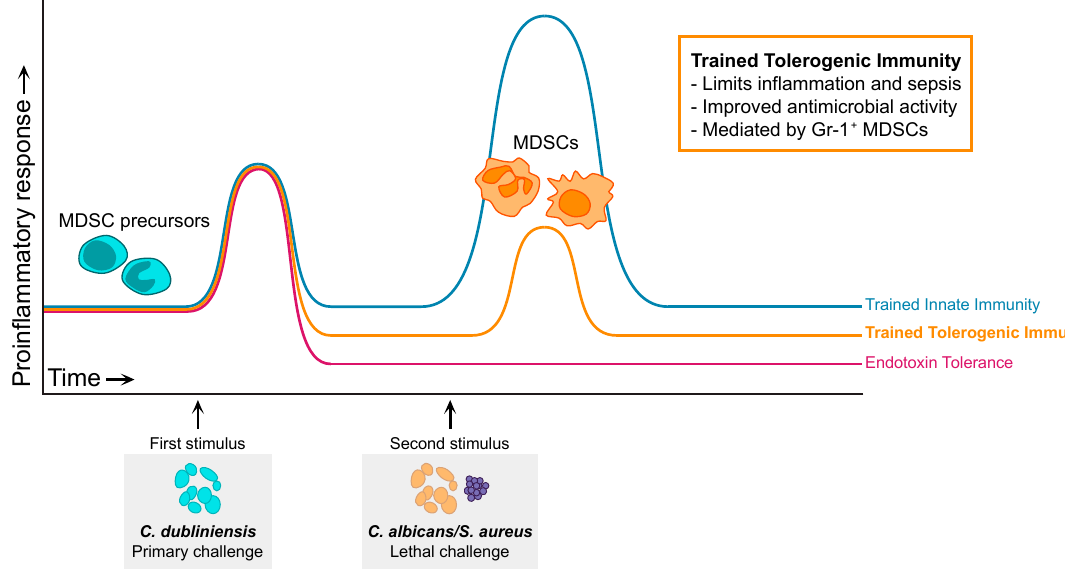
Figure 3. Graphical representation of primary and secondary immune responses associated with the proposed spectrum of trained innate memory, including trained tolerogenic immunity (TTI), trained innate immunity (TII), and endotoxin tolerance (ET). Adapted from [117].